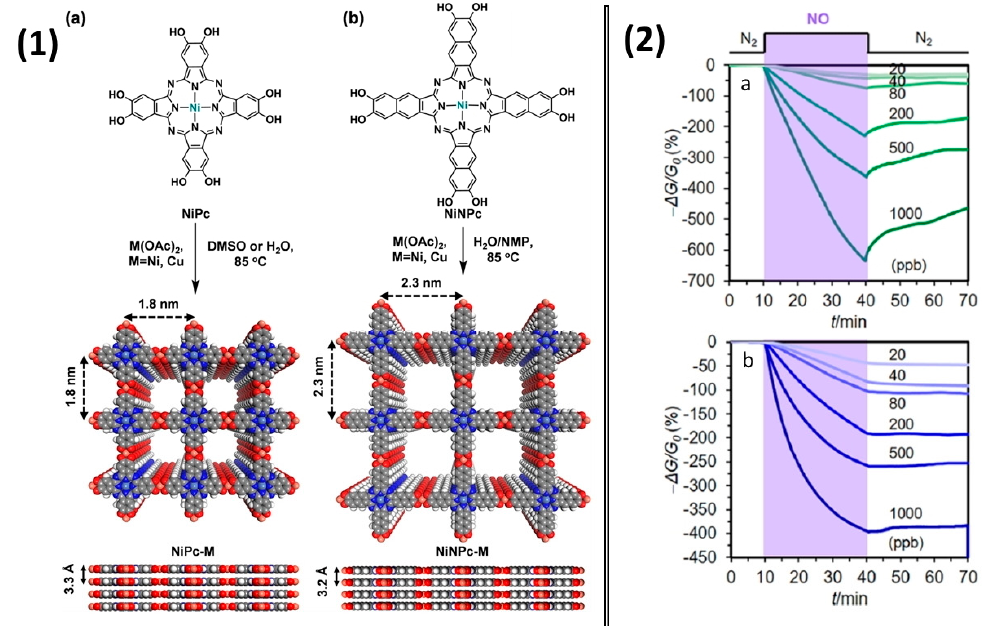
Figure 17. ( a ) Transfer characteristics of a typical SAMFET in vacuum with a 1 µ m SiO 2 gate dielectric in the linear and saturated regime. The device exhibited p-type behavior with a pinch off voltage around 0 V. The inset shows a schematic cross-section of the SAMFET sensor. The chemical structures of the SAM molecule (left) and the NO receptor Fe(TPP)Cl (above) are shown. ( b ) Linear plot of the transfer characteristics of the SAMFET sensor. The measurements performed in vacuum and nitrogen were identical. The transfer curve measured 30 min after exposure and shifted towards positive values for increasing NO concentrations. The inset shows the threshold voltage shift as a function of NO concentration. Adapted with permission from [95]. Copyright 2010 Elsevier.